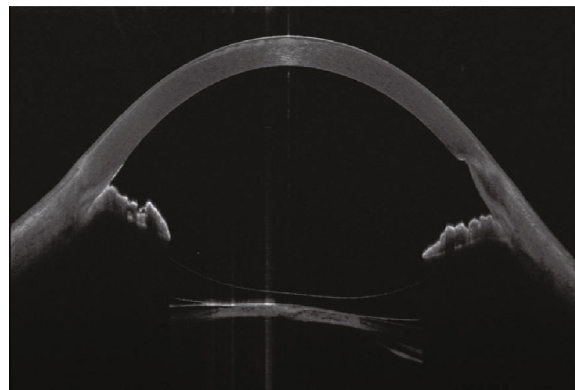
Figure 2: AS OCT of the left